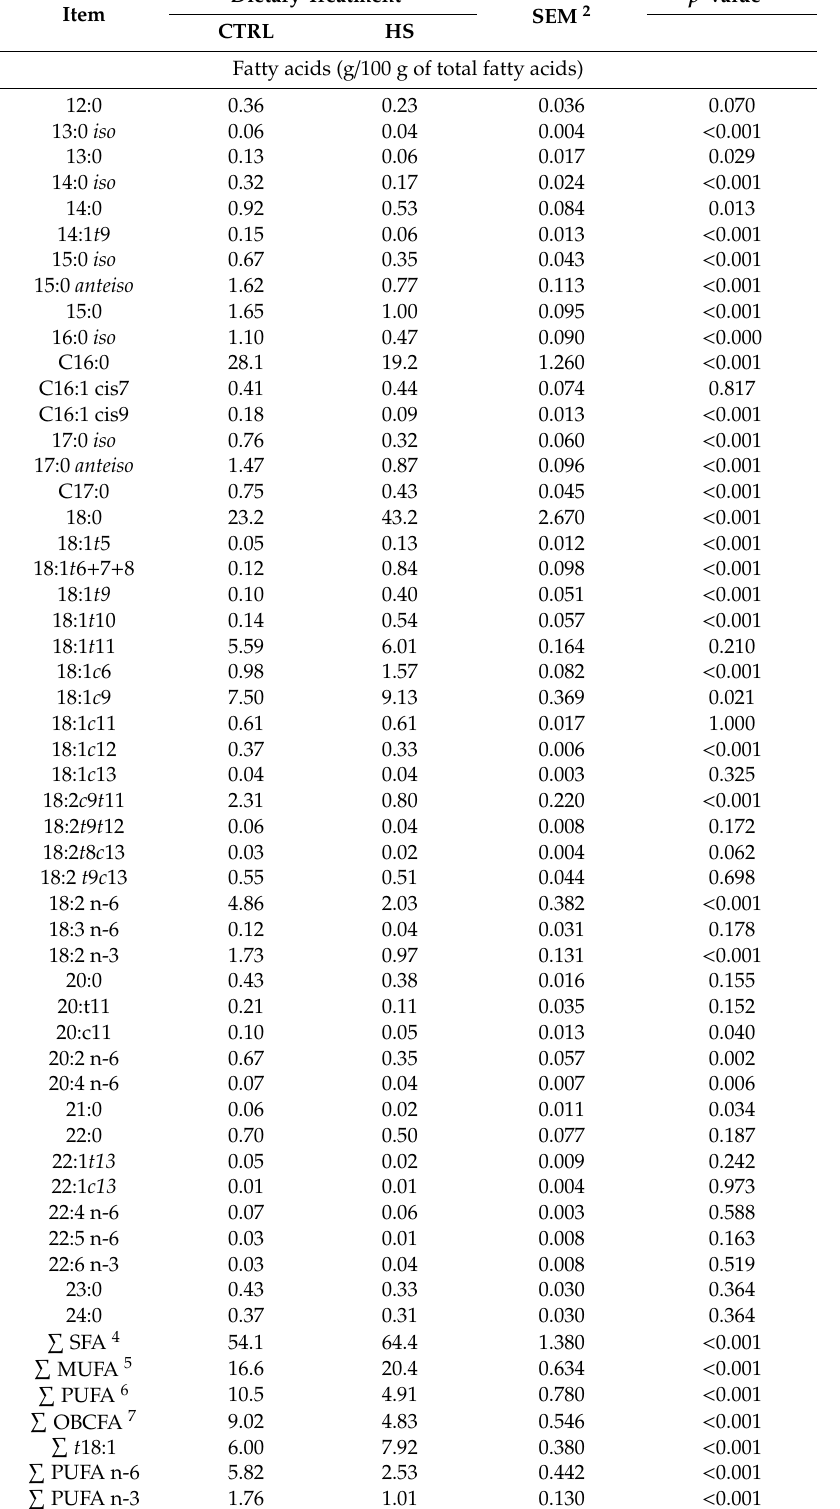
Table 3. The e ff ect of the dietary treatment on rumen content’s fatty acids (g / 100 g of total fatty acids).